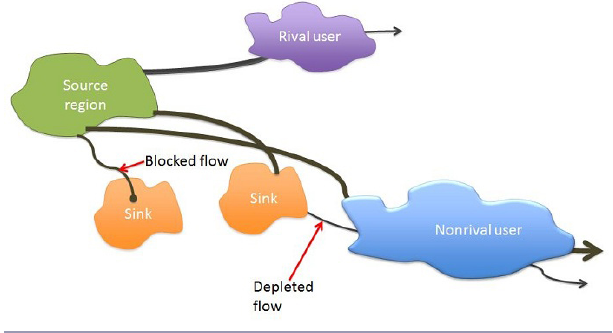
Fig. 1 . Stylized conception of regions of ecosystem service sources, sinks, uses, and flows for a given ecosystem service. Service flows are generated by source regions and depleted by sinks and rival use, but not by nonrival